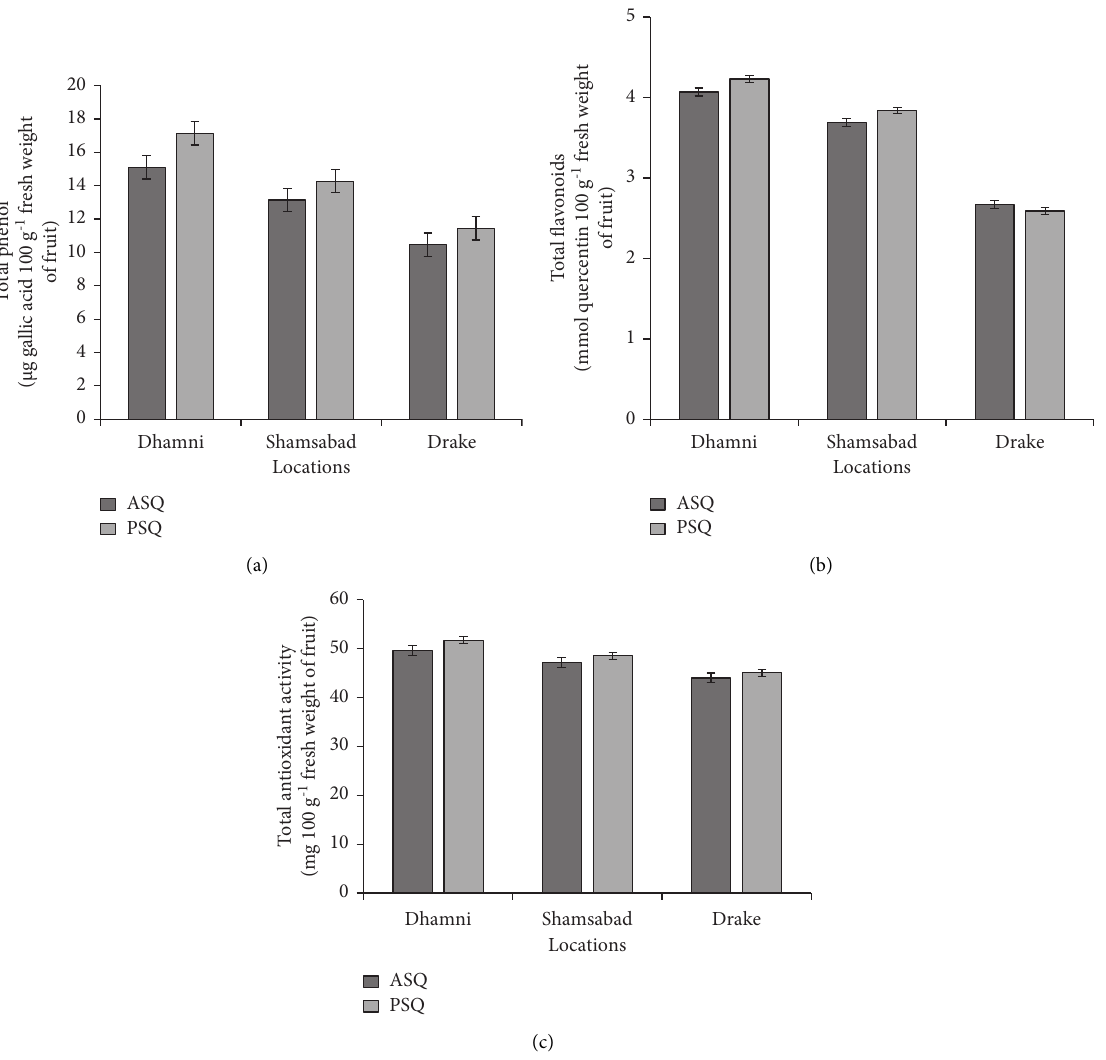
Figure 2: Effect of different elevations on (a) total phenols, (b) total flavonoids, and (c) total antioxidant activity of two different quince ecotypes. ASQ: apple-shaped quince; PSQ: pear-shaped quince. Vertical bars indicate standard error of means ( ± SEM) for three replicates. Table 3: Mineral nutrients of soil and two quince ecotypes from three different locations of Rawalakot, Azad Jammu and Kashmir. Soil Fruit Fruit shape Locations ASQ Shamsabad